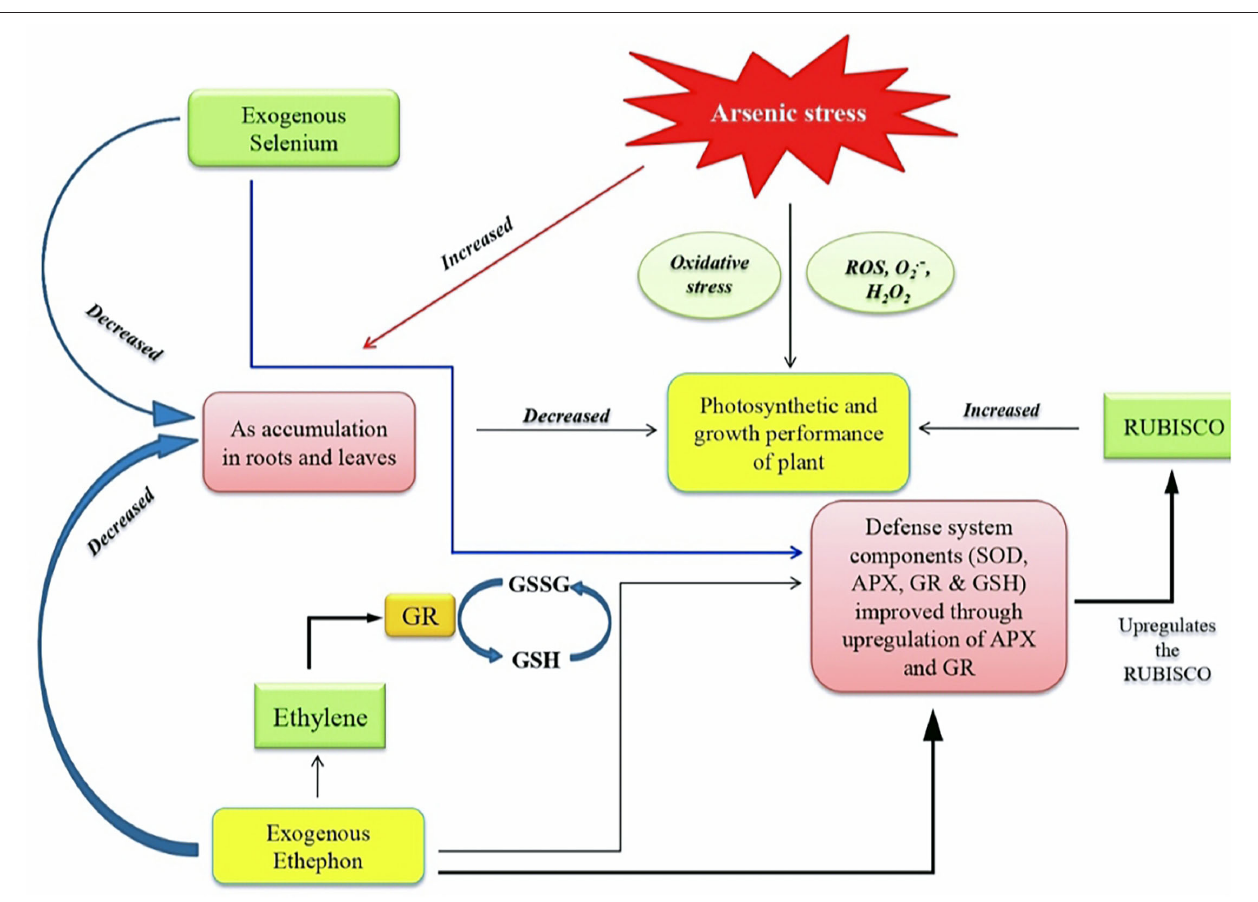
FIGURE 6 | Model showing the impact of As on plants and its reversal employing ethephon (ethylene source) and selenium in plants. As, arsenic; ROS, reactive oxygen species; GSSG, oxidized glutathione, GSH, reduced glutathione; SOD, super oxide dismutase; APX, ascorbate peroxidase; GR, glutathione reductase; RUBISCO, ribulose-1,5-bisphosphate